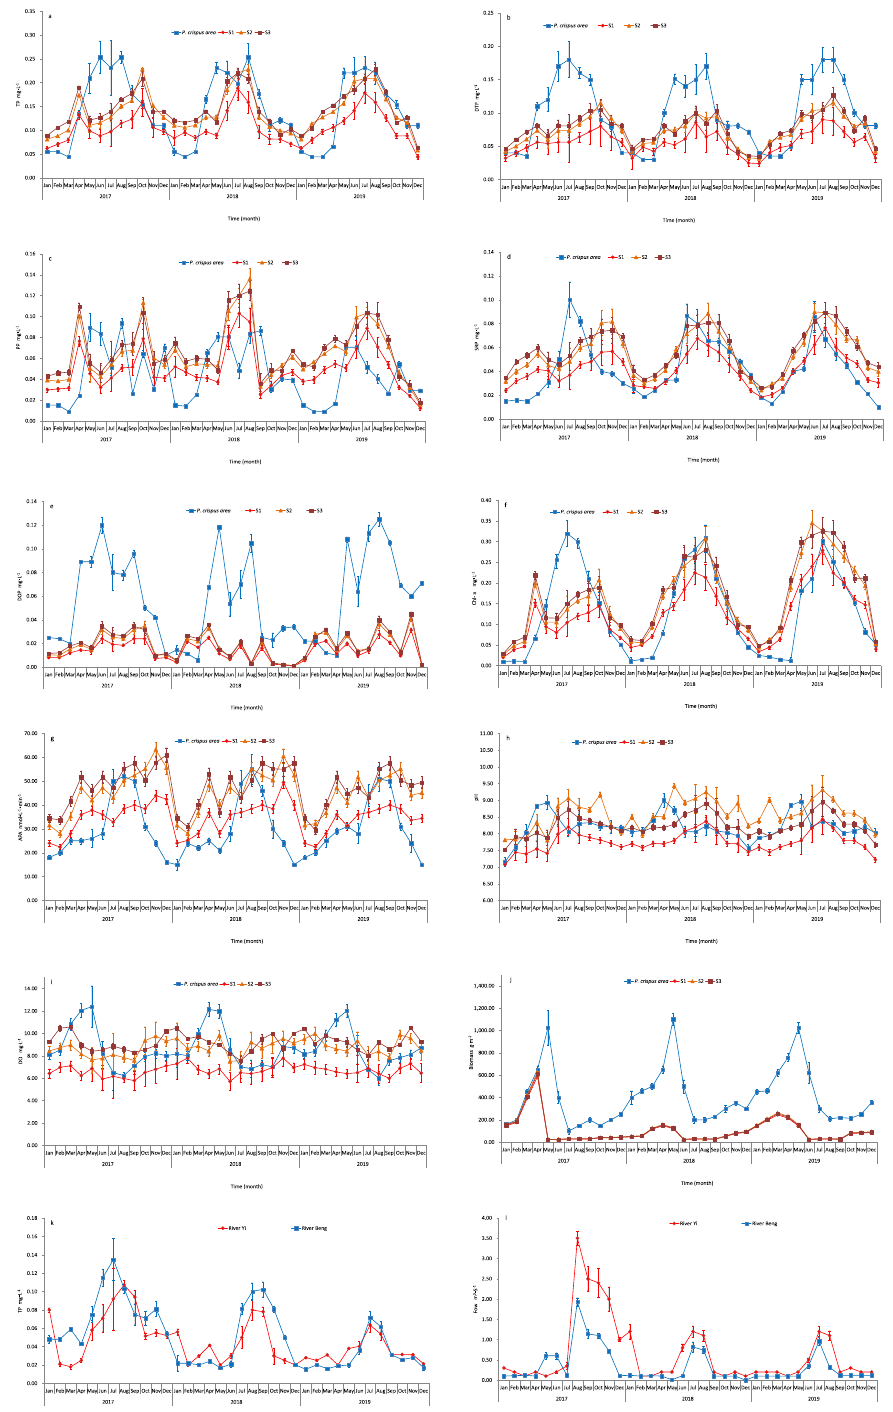
Figure 2. Monthly variations of water chemical and physical parameters (mean ± SD) in different areas of Yimeng Lake from January 2017 to October 2019. a-e water different P fraction concentration in different lake areas; f water chl-a concentration in different lake areas; g water APA concentration in different lake areas; h-i physical parameters in different lake areas. j biomass in different lake areas. k TP concentration of River Yi and River Beng. l the flow velocity of River Yi and River